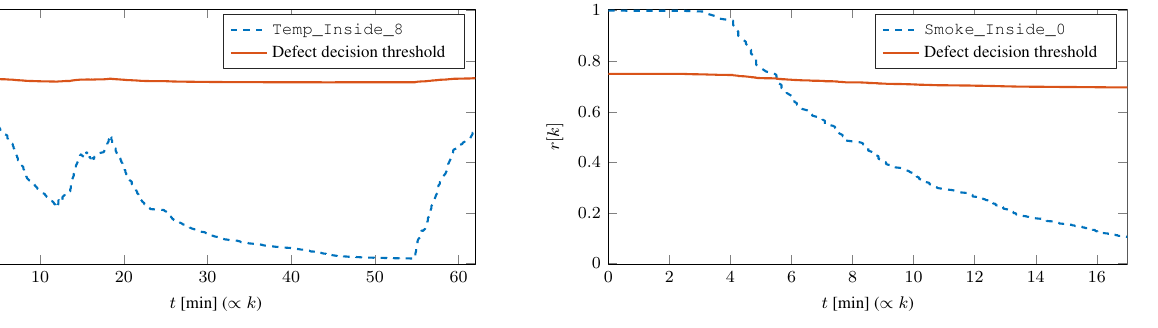
Figure 7. The defect decision threshold ( η = 0 . 75) and the reliabil- ity r [ k ] of the defective sensor Temp_Inside_8 with a random error ( ω = 0 . 01).